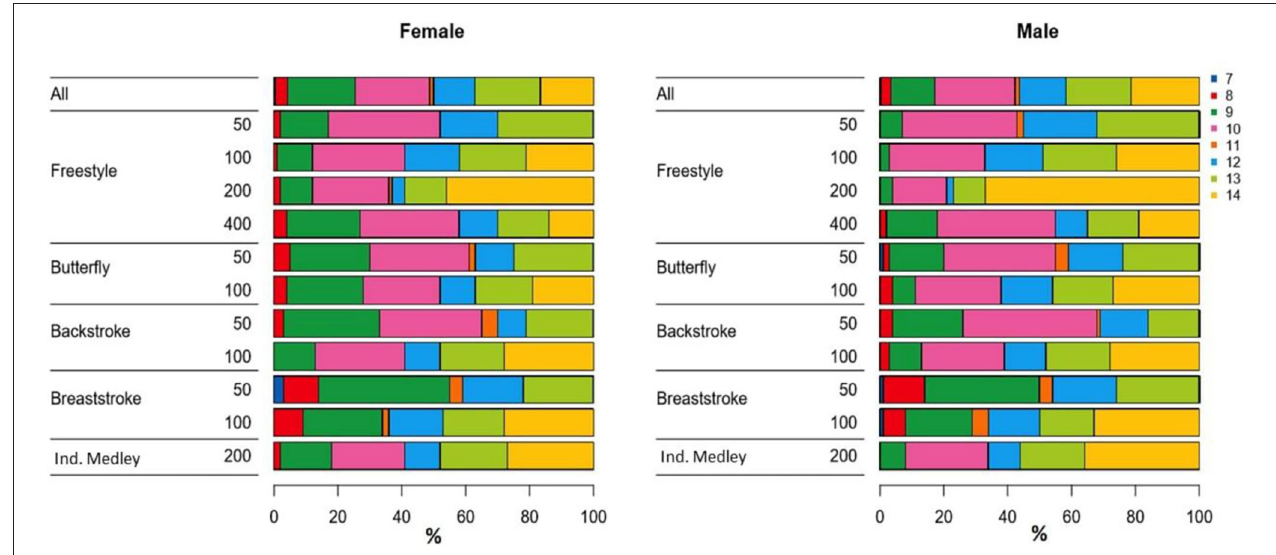
FIGURE 1 | Distribution (%) of female and male Para swimmers by impairment classification and stroke. The colors correspond to the impairment classification from the class 7 (Navy Blue) to class 14 (Yellow).